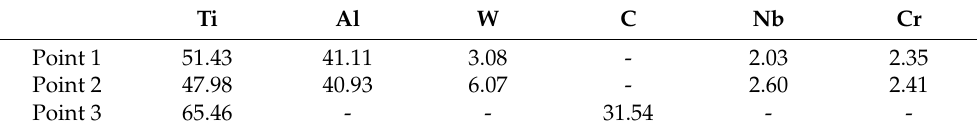
Figure 4. Cross-sectional SEM images of the Ti–48Al–2Cr–2Nb composite coatings: ( a ) 0 WC; ( b ) 5 WC; ( c ) 10 WC; ( d ) 15 WC. ( a1 – d1 ) Enlarged microstructures of the red boxed area in ( a – d ). Table 2. Composition of the Ti–48Al–2Cr–2Nb composite coatings obtained from SEM-EDS analysis.